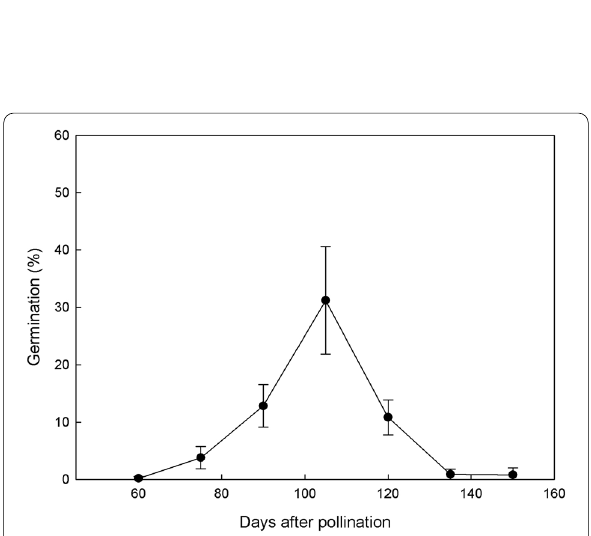
Fig. 4 Mean percent germination of C. subtropicum seeds collected at successive 15 day intervals after pollination on Norstog medium. Data were scored after 6 months of culture. Error bars represent SE (n